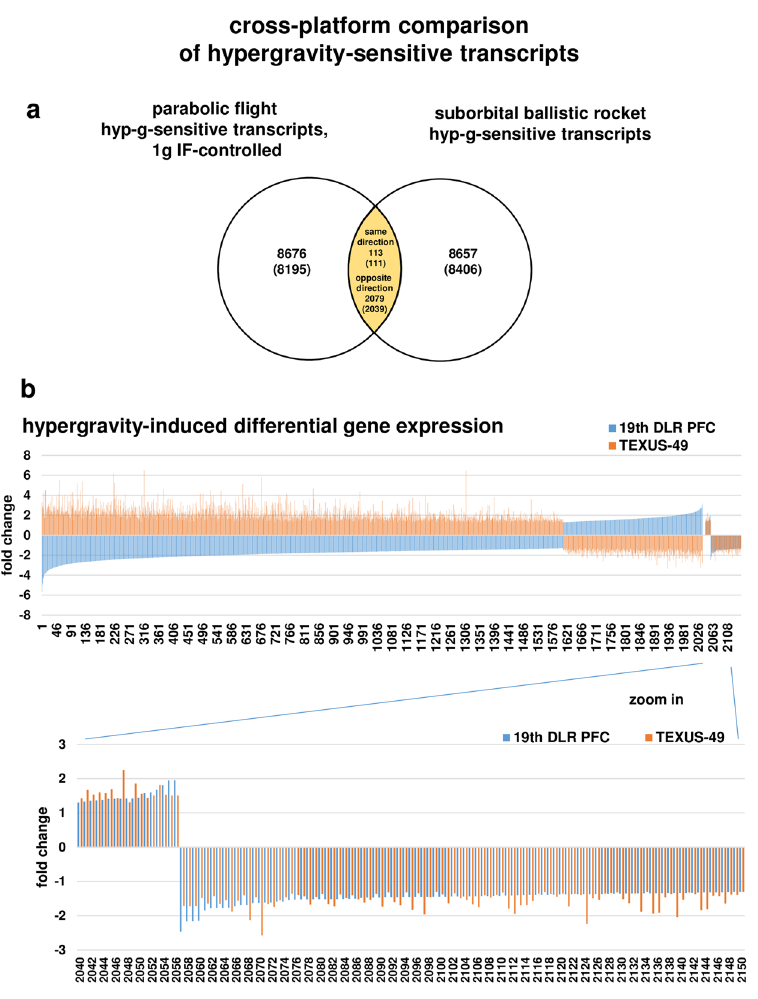
Figure 7. Hypergravity-sensitive transcripts are reversely regulated when comparing 20 s (19 th DLR Parabolic Flight Campaign) and 75 s (TEXUS-49 suborbital ballistic rocket campaign) exposure times. ( a ) Venn diagram showing the intersection of hypergravity-sensitive transcripts of both platforms. ( b ) Graphical display of transcripts (annotated transcripts) showing that transcripts are mostly regulated in the opposite direction. Only 113 from 2192 transcripts were regulated in the same direction. Fold changes (FCs) are ratios between the averages of linear expression values. If the ratio is < 1, FC is calculated as the negative reciprocal of the